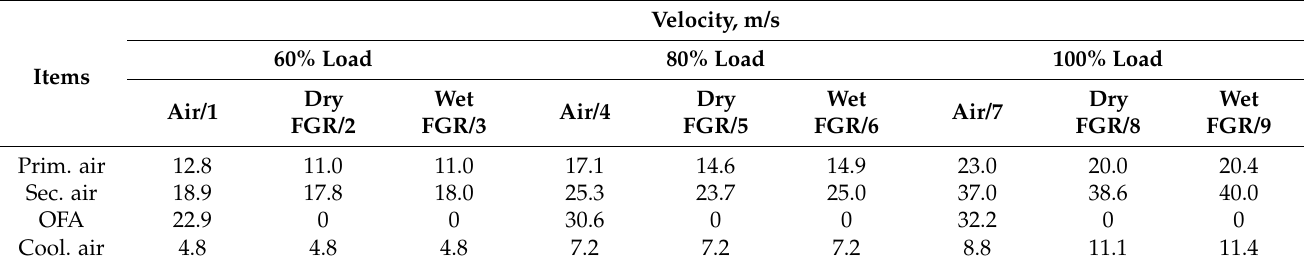
Table 2. Velocity of the flow rates at the inlet of the